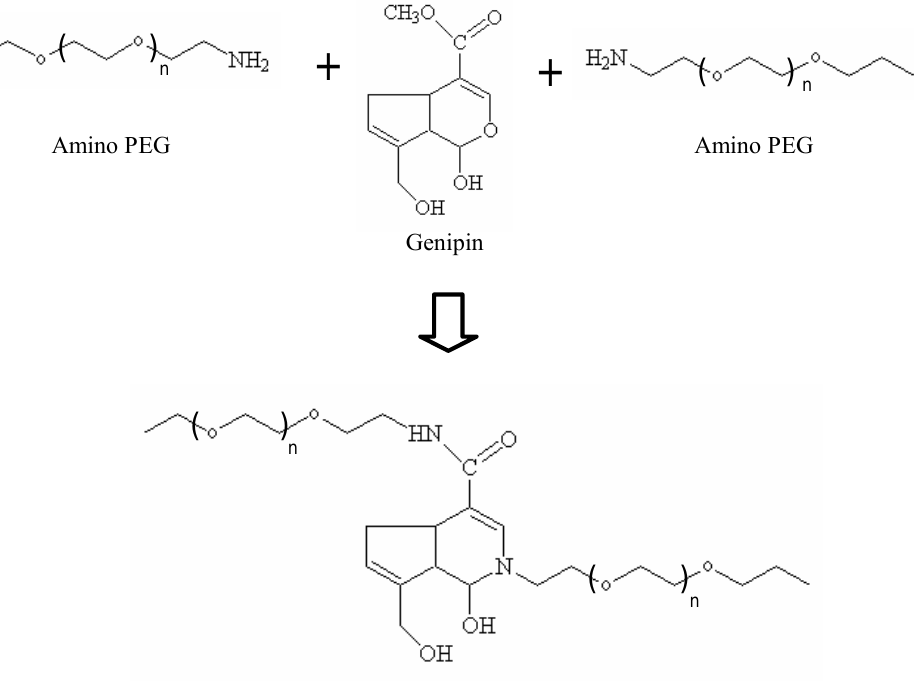
Figure 3. The reaction scheme of amino PEG-genipin